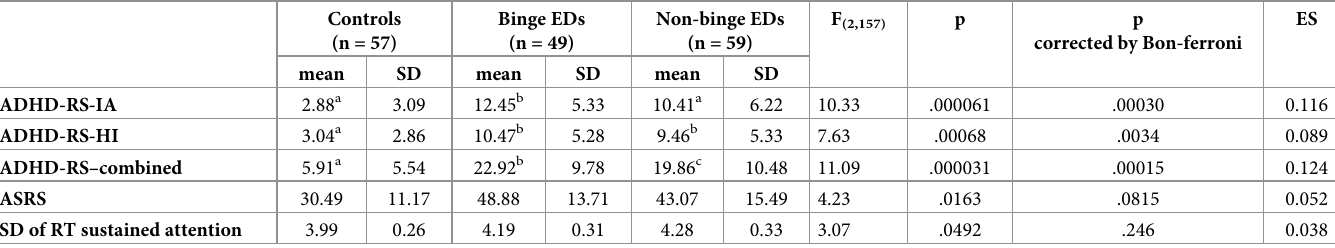
Table 4. Assessment of attention functioning: Three-group analysis (ANCOVA).